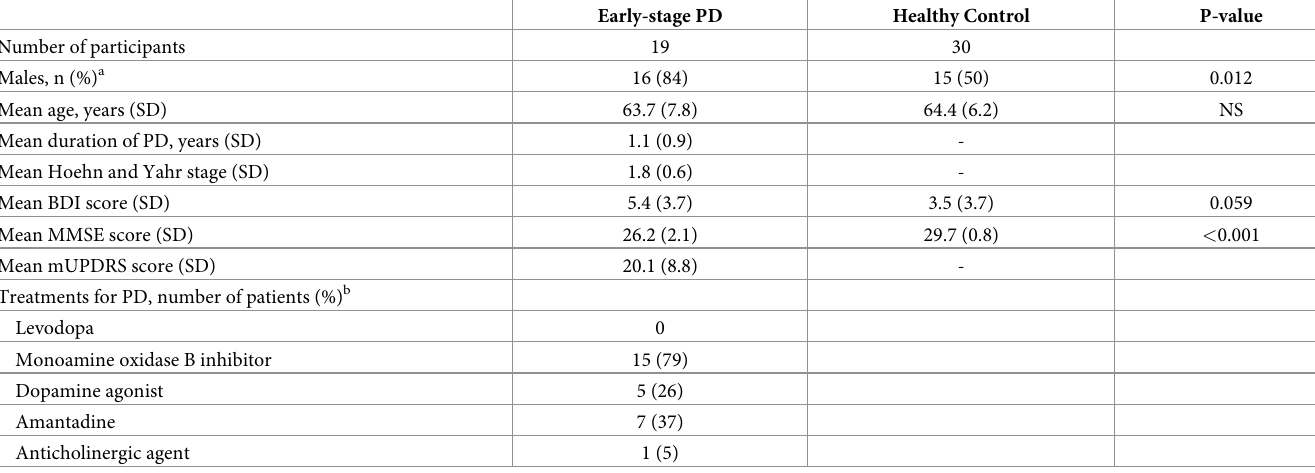
Table 1. Demographic and clinical characteristics of participants included in the BNA neuromarker.